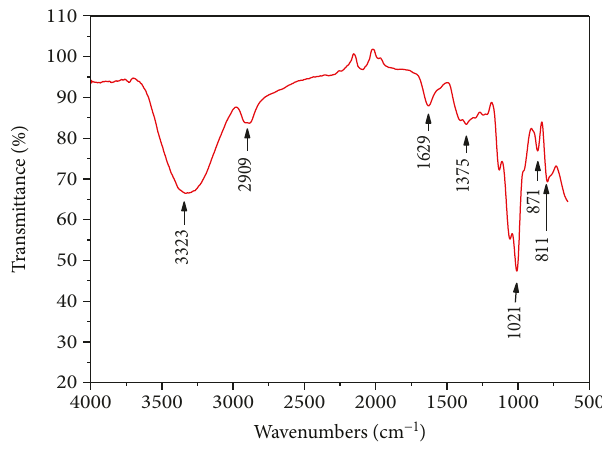
Figure 2: FTIR spectra of